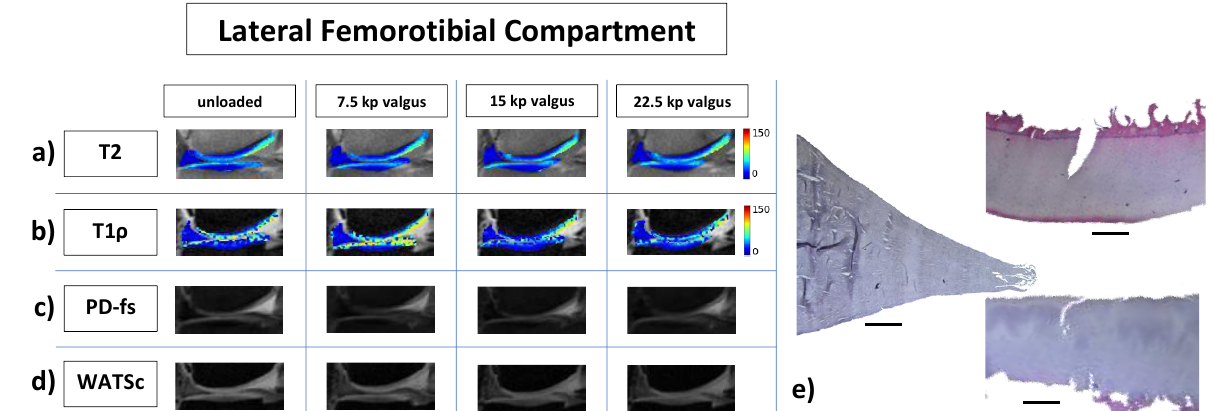
Figure 3. Representative multiparametric MR images of the lateral femorotibial compartment in response to varus loading and corresponding histologic sections. MR images ( a–d ) are organized as in Figure 2. For the histologic sections ( e ), the lateral meniscus (left side) is positioned between the femoral (top) and tibial cartilage (bottom). Same right knee joint as in Figures 1 and 2.